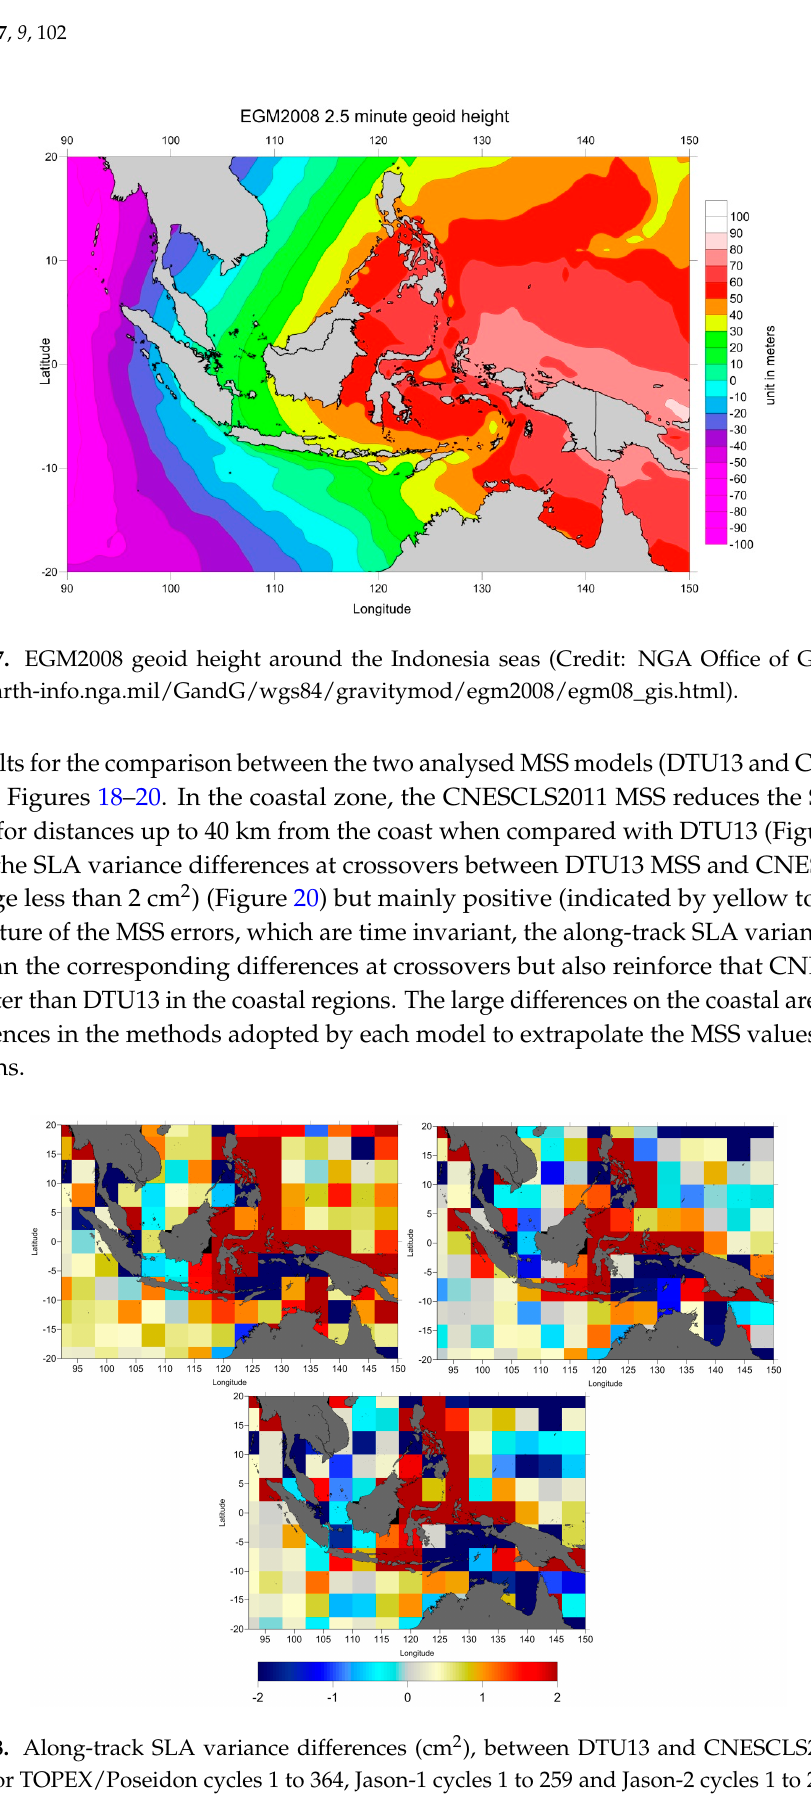
Figure 19. SLA variance differences (cm 2 ) function of distance from the coast between DTU13 and CNESCLS2011 MSS models for TOPEX/Poseidon cycles 1 to 364, Jason-1 cycles 1 to 259 and Jason-2 cycles 1 to 280.